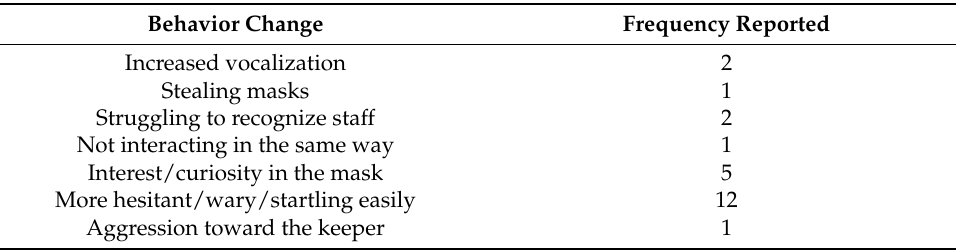
Table 5. An overview of the behavioral changes reported by keepers during keeper–animal interac- tions when wearing face